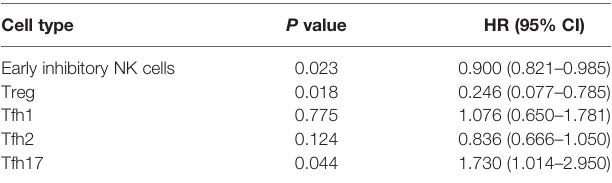
TABLE 5 | Logistic regression analysis of the effect of the fi ve peripheral blood lymphocyte subsets on the